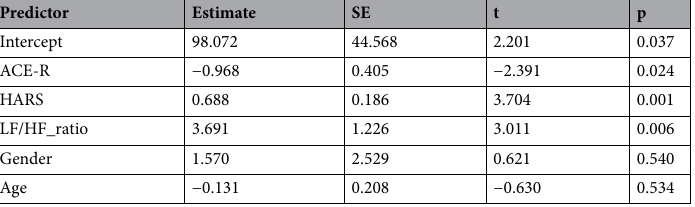
Table 5. Model coefficients. Apathy Evaluation Scale (AES) during pandemic as dependent variable of a multiple regression model. SE standard error, ACE-R Addenbrooke’s cognitive examination—revised version, HARS Hamilton Rating Scale for Anxiety, LF/HF low-frequency/high-frequency ratio.